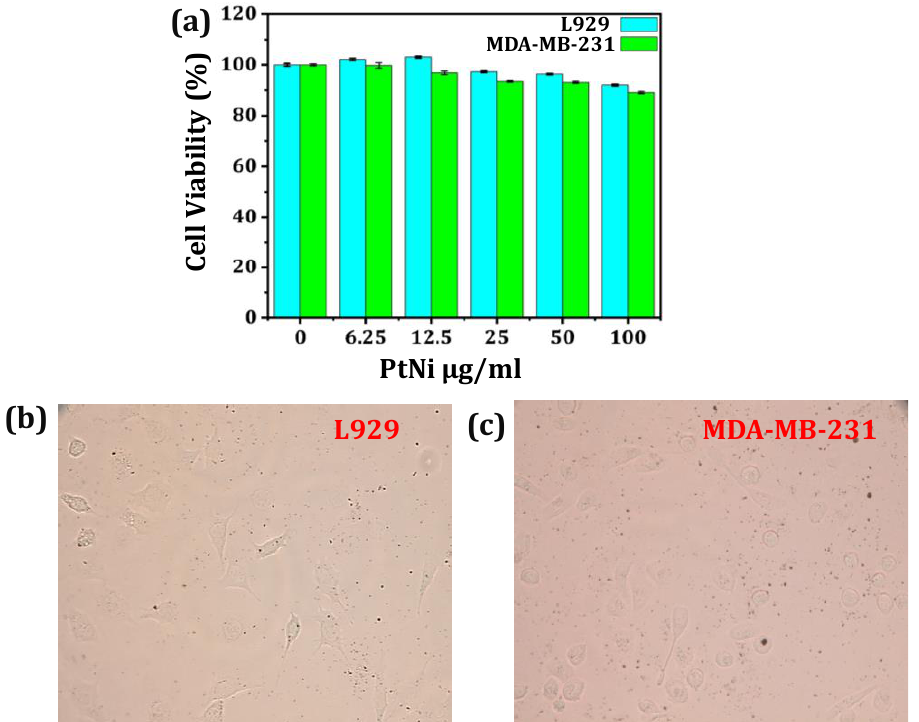
Figure 9. ( a ) Cell viability of L929 and MDA-MB-231 cells, microscopic images of ( b ) L929 and ( c ) MDA-MB-231 cells.